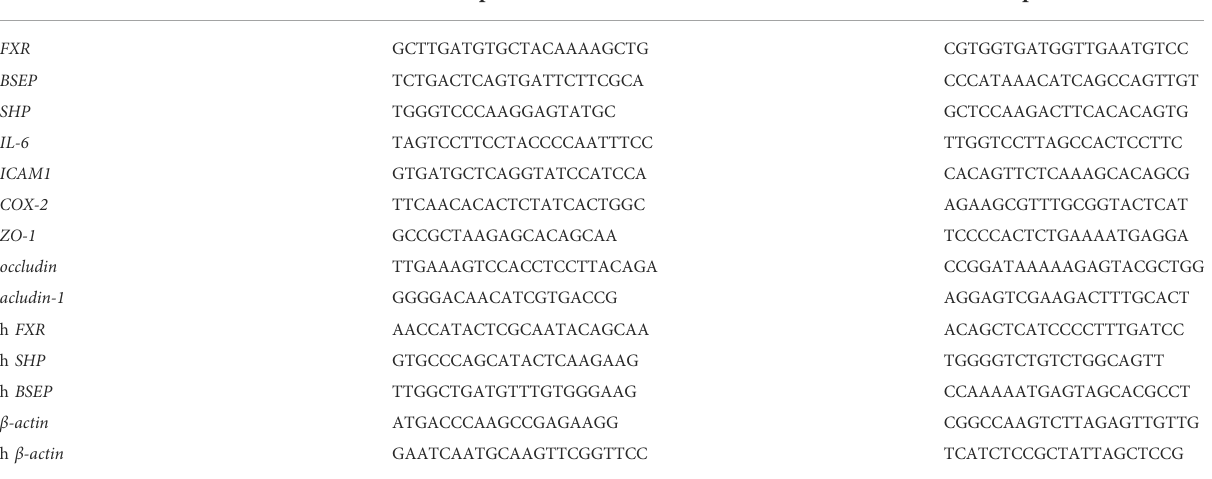
TABLE 1 Primers used in qPCR.